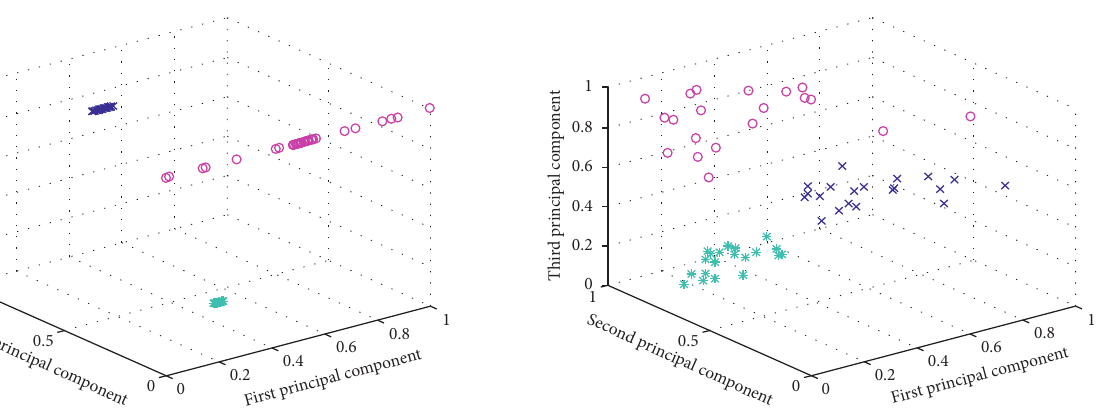
Figure 6: Recognition rate (100%) of training data.